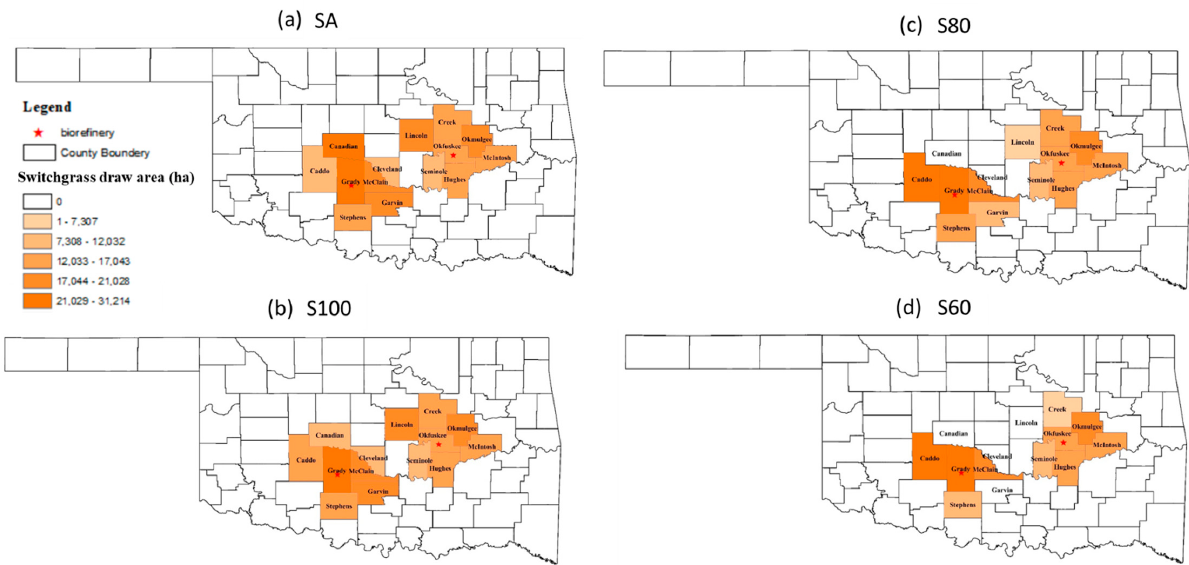
Figure 2. Switchgrass draw area and locations under scenarios. ( a ) SA-100% of the time the biorefinery annual demand can be met; ( b ) S100-probability of meeting biorefinery demand is 35%, 45%, and 55% for the first three years respectively, and 100% for years 4 to 10; ( c ) S80-probability of meeting biorefinery demand is 35%, 45%, and 55% for the first three years respectively, and 80% for years 4 to 10; ( d ) S60-probability of meeting biorefinery demand is 35%, 45%, and 55% for the first three years respectively, and 60% for years 4 to 10.